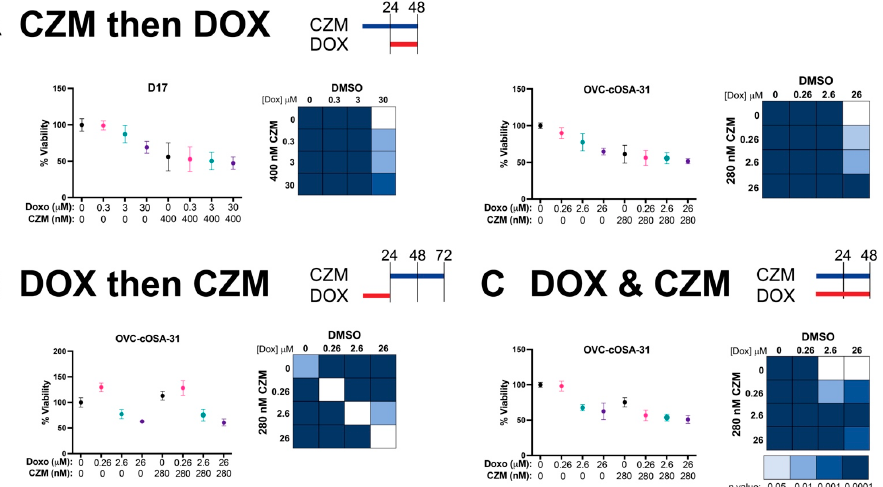
Figure 6. Capzimin sensitizes OS cells to doxorubicin (Dox) treatment. D17 or OVC-cOSA-31 cells were treated with subjected to three different conditions to evaluate CZM’s efficacy combined with Dox. ( A ) In the CZM and then Dox conditions, cells were treated with DMSO or their respective CZM for 24 h and then subjected to their IC 50 dose of doxorubicin (30 μ M for D17 and 26 μ M for OVC-cOSA-31) or 10-fold or 100-fold lower concentrations for an additional 24 h. ( B ) In the Dox and then CZM condition, cells were treated with Dox for 24 h, after which, the media was removed and media with DMSO or CZM was replaced for 48 h. ( C ) In the Dox & CZM condition, cells were subjected to co-treatment of both compounds for 48 h. After each experimental time course, viability was measured by incubating with resazurin for 8 h and measuring absorbance at 570/600 nm (six technical replicates per treatment). Graphs depict normalized % viability, mean ± SD from n = 3 independent experiments, except for part C, where n = 2 independent experiments. Chart depicts select statistically significant differences as determined by a two-way ANOVA with a post-hoc Tukey’s multiple comparison test. Non-filled squares indicate no significant differences were ob- served.